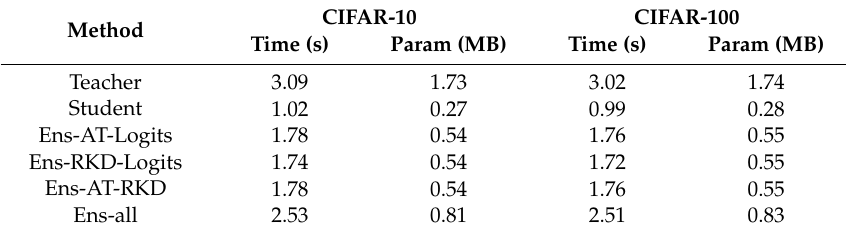
Table 2. Computational time for inference of test set and the size of